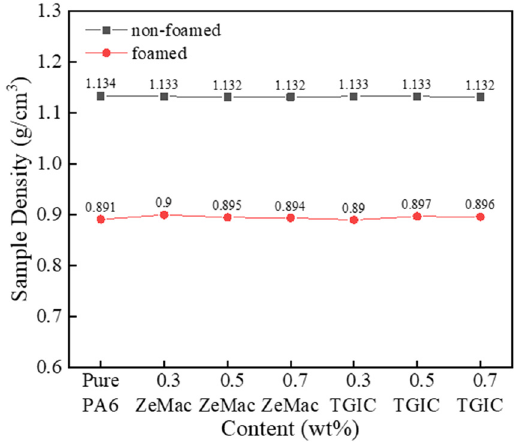
Figure A5: Density of nonfoamed samples and foamed samples.